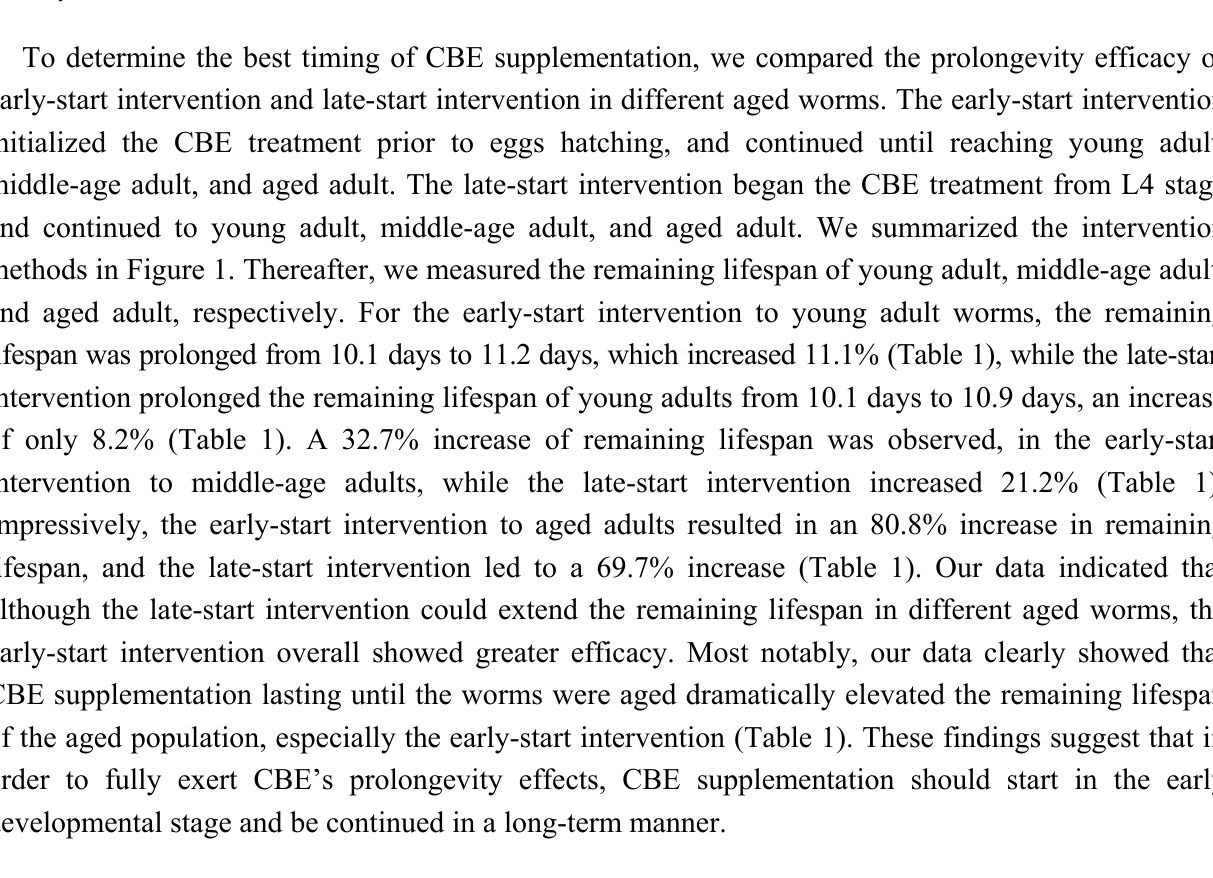
Table 1. The remaining lifespan of different aged worms at 25 °C. Lifespan and standard error are shown in